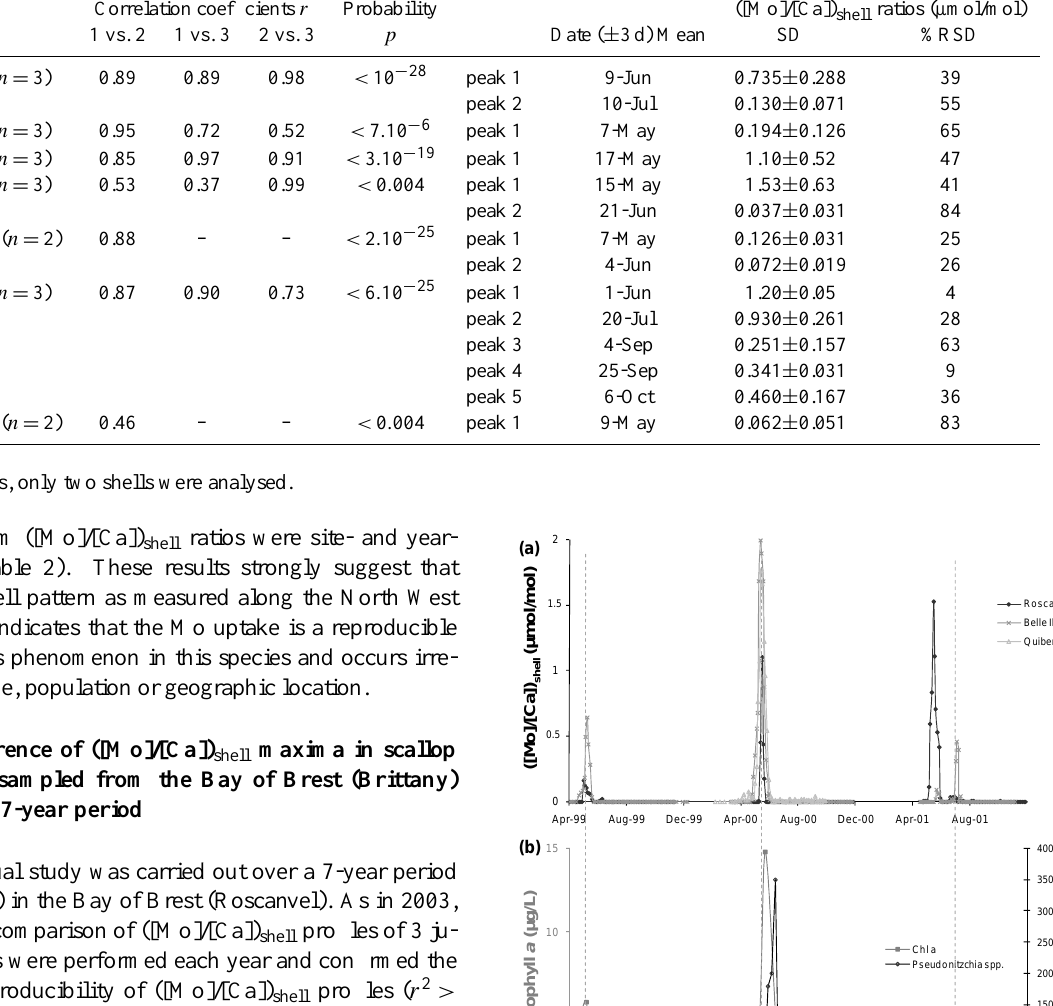
Table 1. Intershell comparison of ([Mo]/[Ca]) shell ratio profiles archived in Pecten maximus shells from a same population (Bay of Brest, Roscanvel station) over a 7-year period (1998–2004) and presentation of ([Mo]/[Ca]) shell peaks (named in chronological order) observed for each year. The maximum of ([Mo]/[Ca]) shell ratios and the date of this maximum were averages from 3 shells (except 2002 and 2004). Intershell reproducibility of Mo profiles Molybdenum shell enrichments n = 19